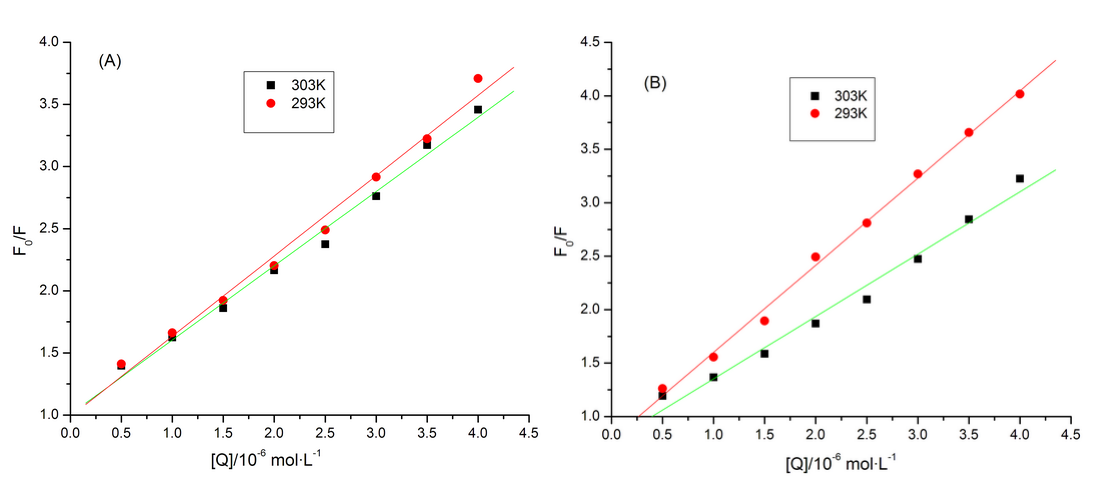
Figure 2. Stern-Volmer plots for the quenching of CYPs by puerarin at different